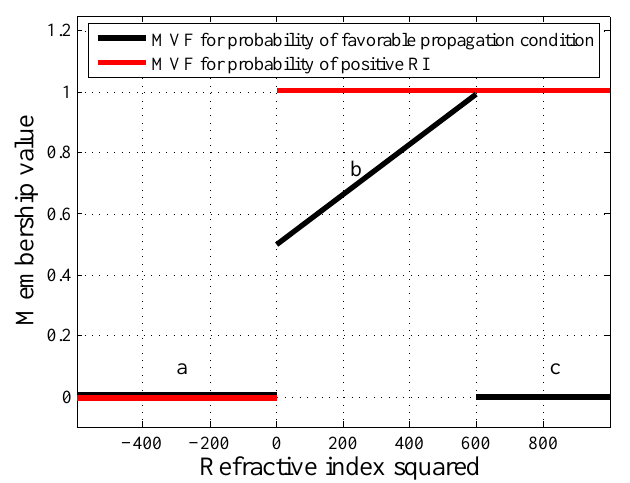
q φ q φ (left) and a 2 (right) for DJF in the Northern Hemisphere. u 10